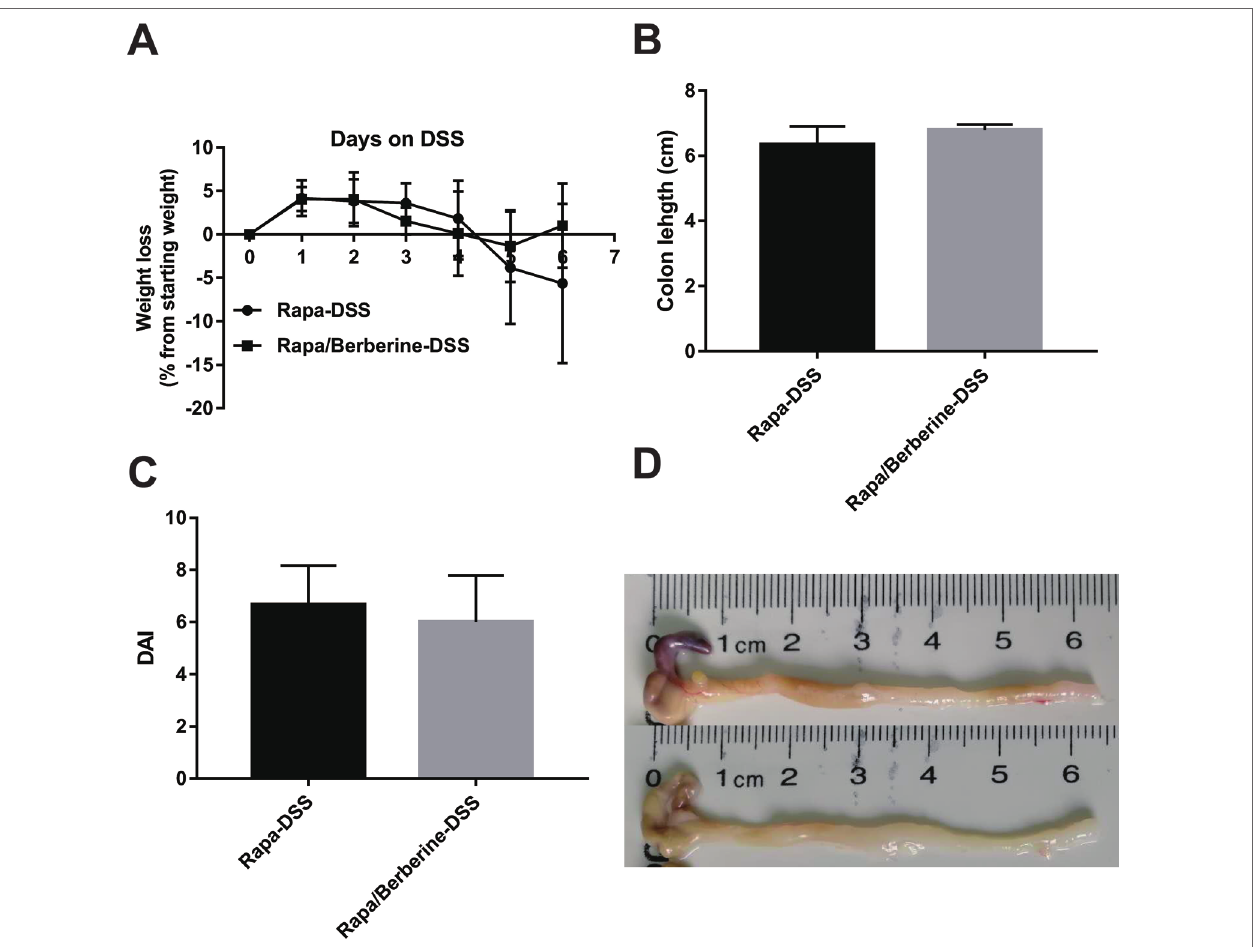
FIGURE 7 | Effect of berberine against DSS-induced colitis when rapamycin was used to inhibit mTORC1 signaling. The weight loss (A) was calculated daily, and the colon length (B) , DAI (C) and pictures of colon (D) were determined on day 6 post DSS administration. Data were pooled from two independent experiments with n = 6 mice per